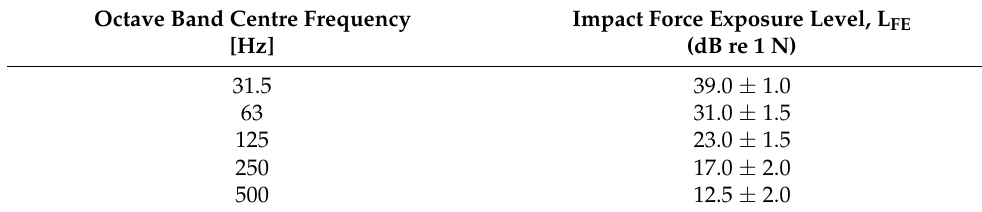
Table 2. Impact force exposure level octave band of the rubber ball